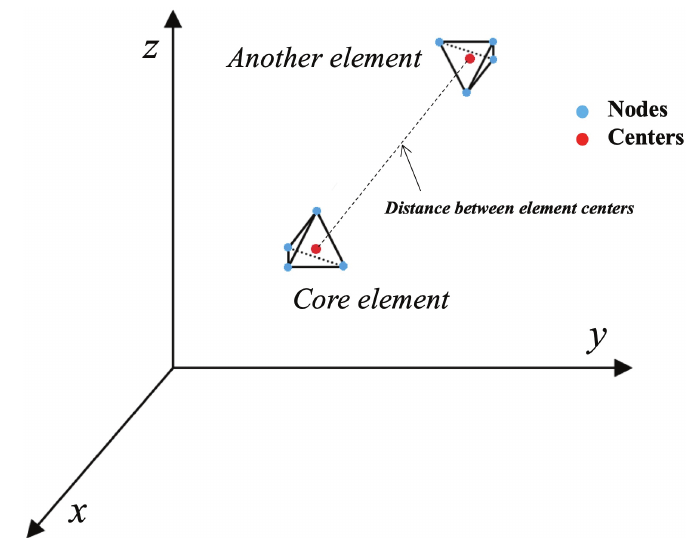
Figure 1. Relationship between the core element and the detected